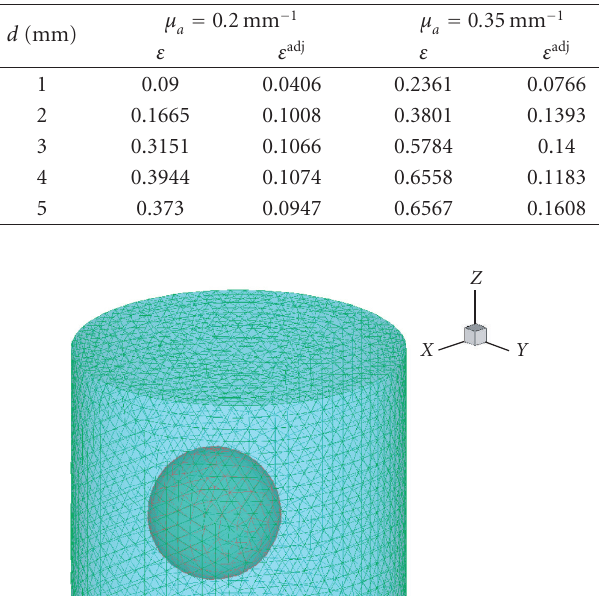
and 0.35 mm − 1 , respectively. The reduced scattering coe ffi - cients were 1.05 mm − 1 and the refractive indices were